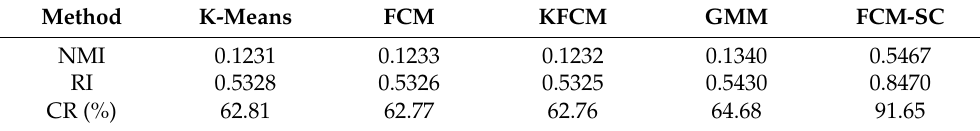
Figure 13. Classification results of SVM and LDA in corn kernel mildew hyperspectral image data (spectral and image features) ( a ) SVM and ( b ) LDA.